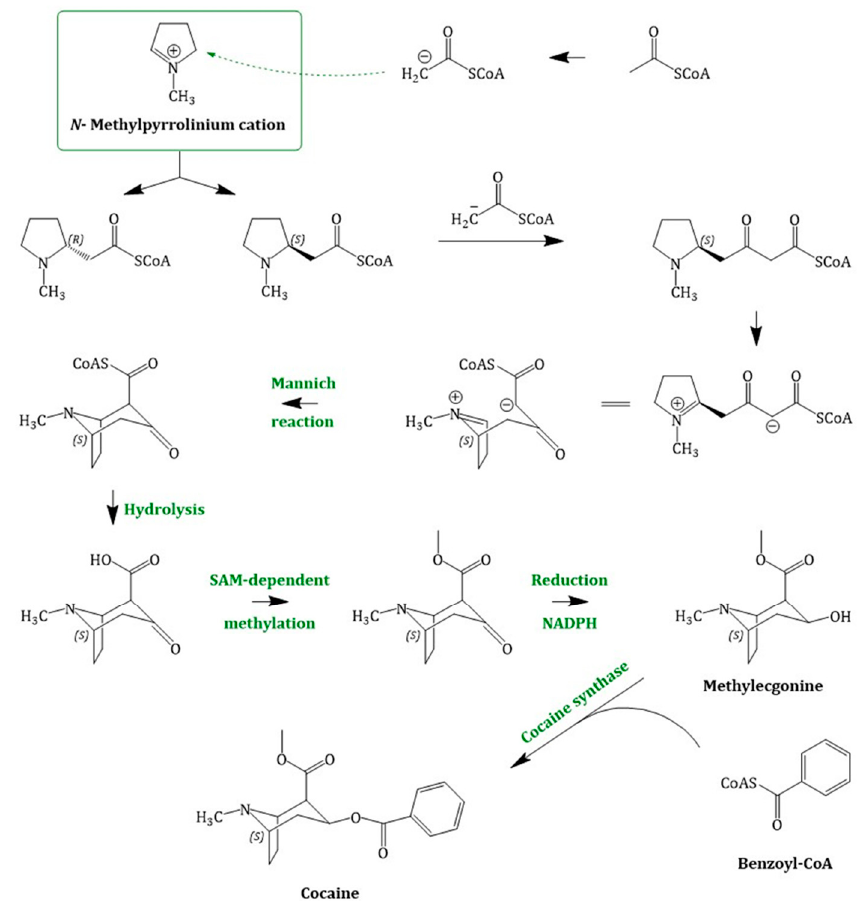
Figure 5. Cocaine biosynthesis, starting with the intermediate N -methyl- ∆ 1 -pyrrolinium cation; only less information regarding the enzymatically involvement is proven. The iminium cation reacts with two acetyl-CoA moieties to an intermediate that cyclizes in an intramolecular Mannich reaction. After hydrolysis, methylation and reduction methylecgonine is formed. The cocaine synthase catalyses the last step in the pathway: the condensation of methylecgonine with benzoyl-CoA.